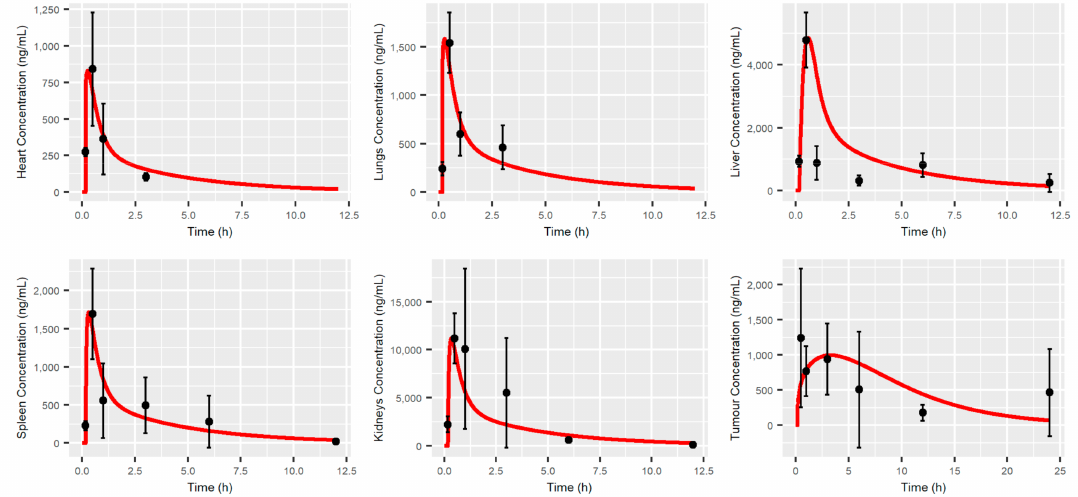
Figure 3. Tissue and tumor concentration-time profiles after the IP single dose administration of 10 mg / kg of MBQ-167 in mice. Red line represents the typical simulated individual. Black dots represent the mean of all observations at the sample time with the corresponding 95% Confidence Interval (vertical